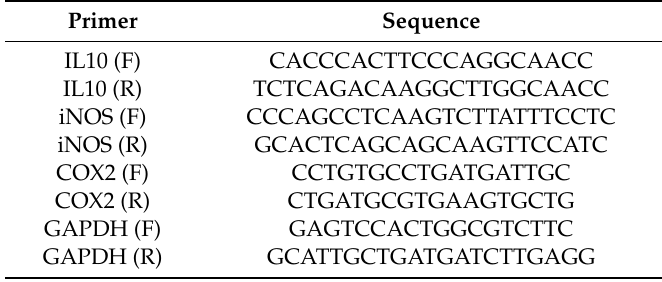
Table 1. Sequences of primers used in the immunomodulation